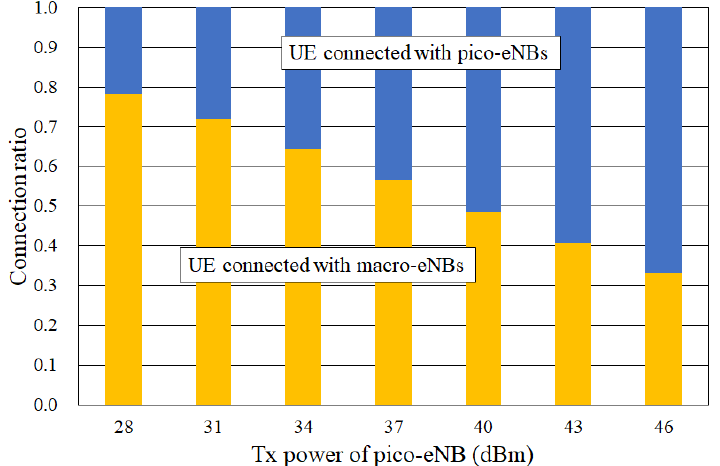
Figure 7. Connection ratio of UE as a function of pico-eNB Tx power.